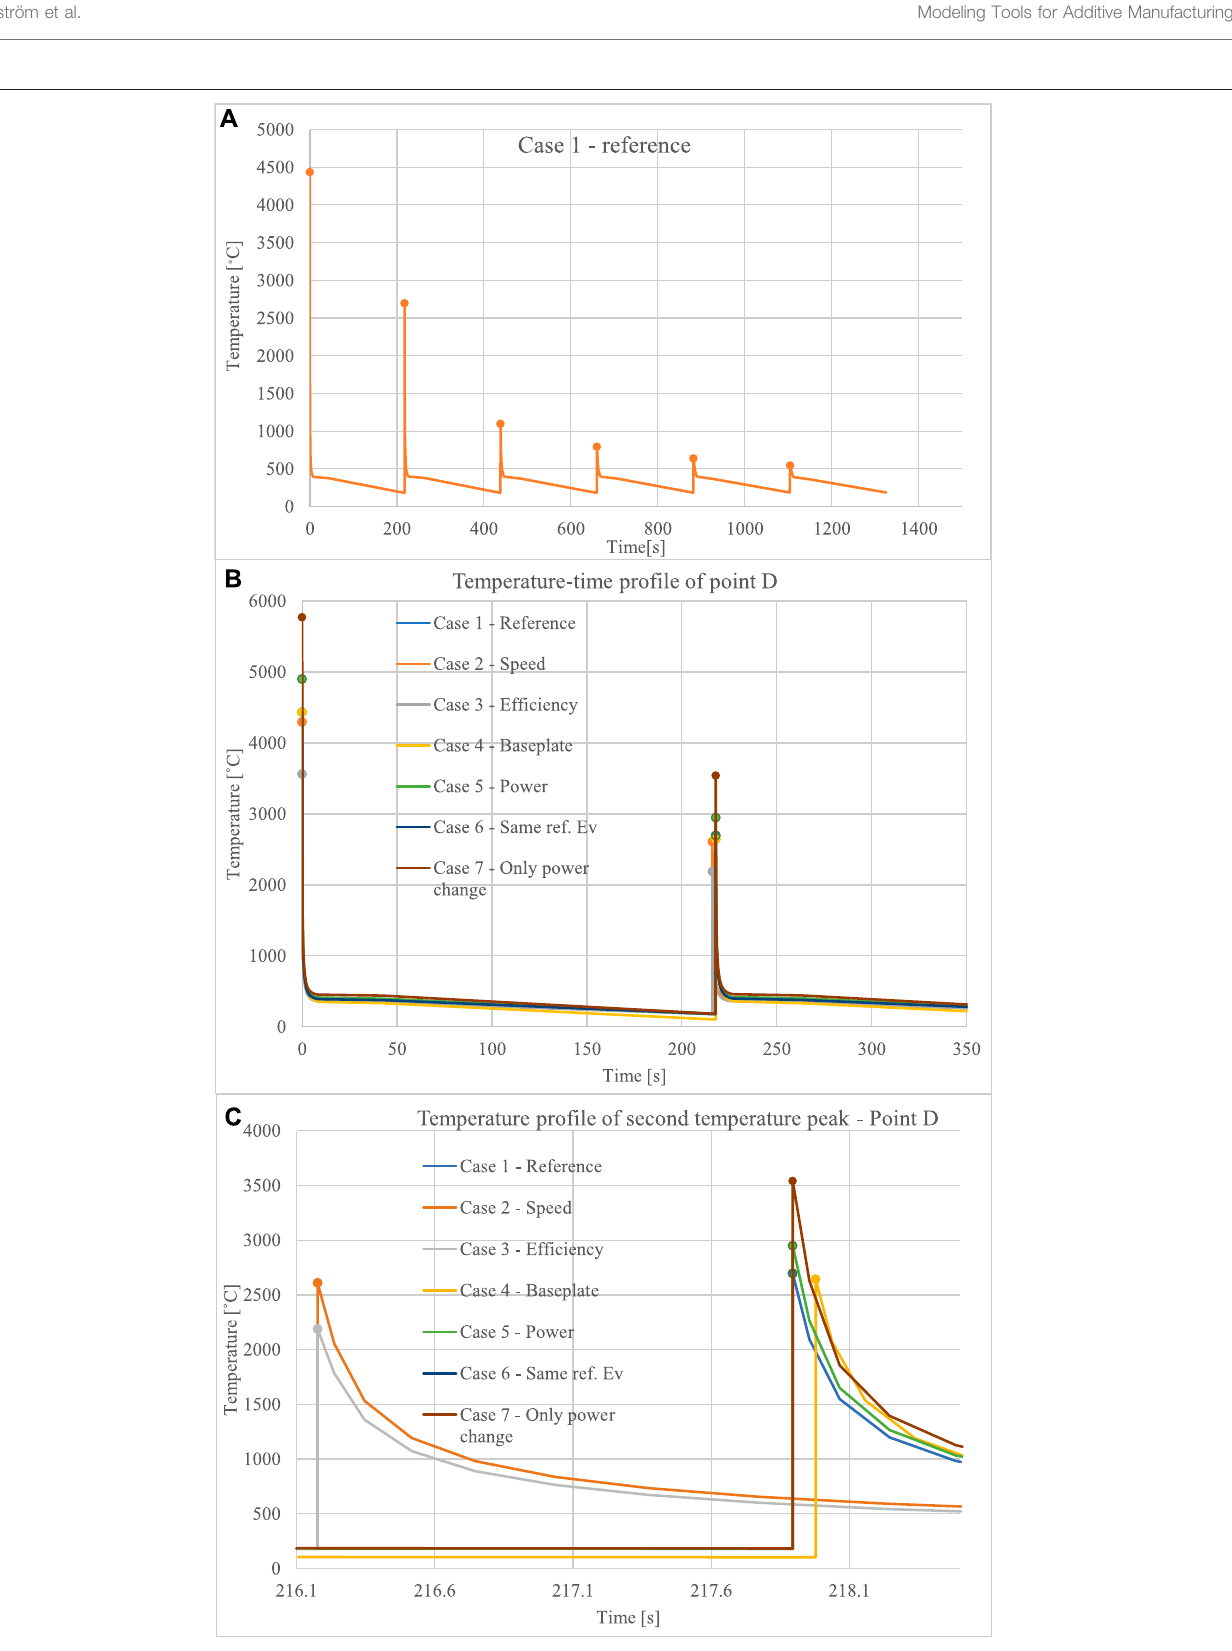
Frontiers in Materials |